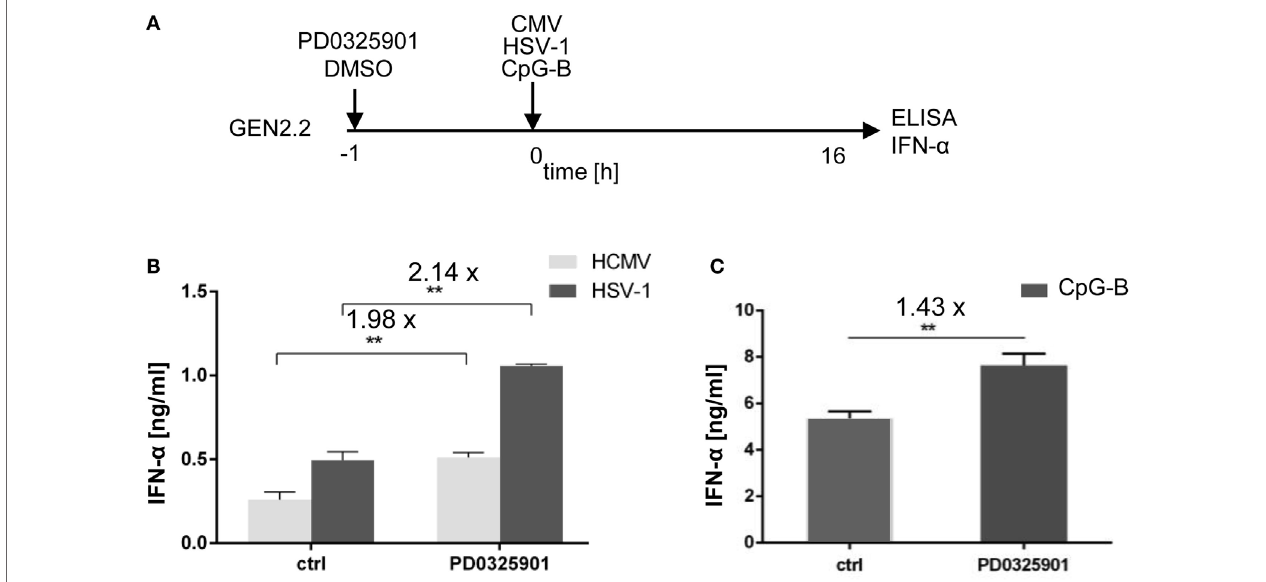
FigUre 2 | Effect of MEK1/2 inhibitor PD0325901 on the potentiation of IFN- α production stimulated with HSV-1, human cytomegalovirus (HCMV), or CpG-B. (a) Experimental outline. GEN2.2 cells separated from MS-5 feeder cells were incubated with the MEK1/2 inhibitor PD0325901 (1 µM) for 1 h before stimulation with HSV-1 or HCMV at the MOI of 10 TCID 50 per cell, or with 4 µg/ml CpG-B. After a 16 h culture, the IFN- α production was determined in the cell-free supernatants by ELISA. N = 3, **, p < 0.01; two-tailed Student’s t -test. (B) The production of IFN- α by GEN2.2 cells stimulated with HSV-1 or HCMV in the presence or absence of PD0325901. (c) The production of IFN- α by GEN2.2 cells stimulated with CpG-B in the presence or absence of PD0325901. The data show mean and SEM of three independent experiments. N = 7, **, p < 0.01; two-tailed Mann–Whitney